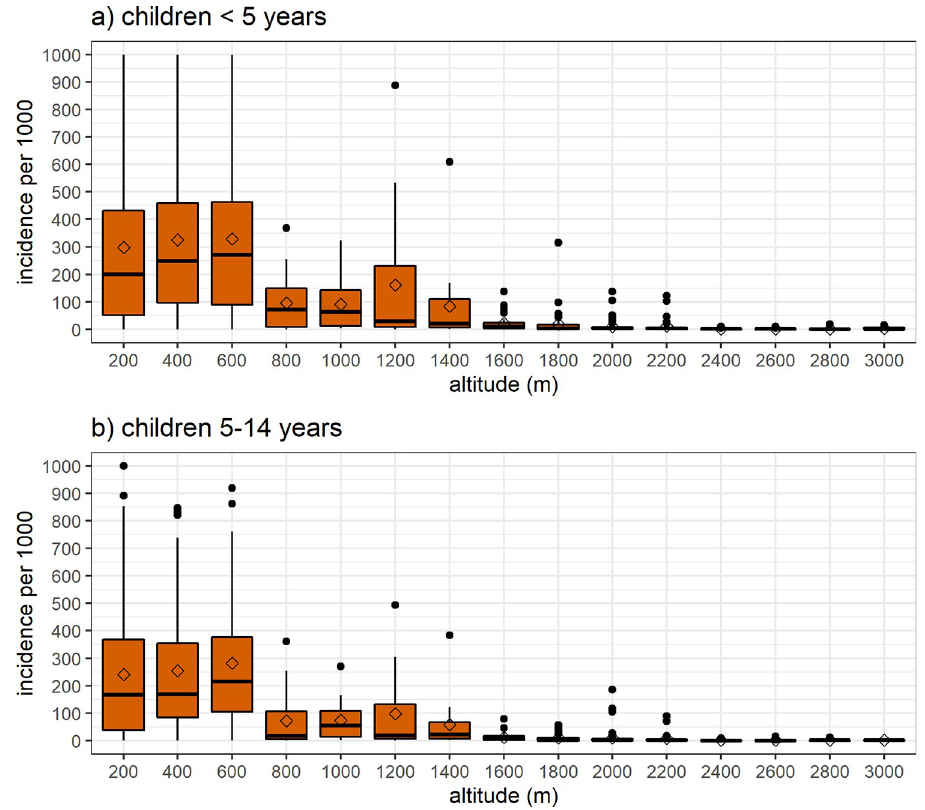
Fig 5. Average annual malaria incidence in catchment areas of health facilities among age groups < 15 years, PNG (2011–2019). Incidence rates per 1000 among: a) children under five years old (U5), c) adolescents (5–14) years